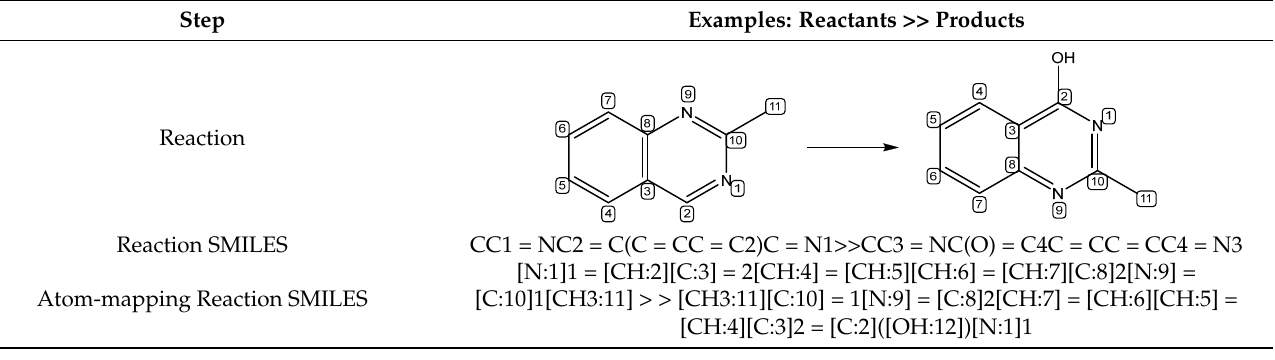
Table 2. Data preprocessing steps of WLN.